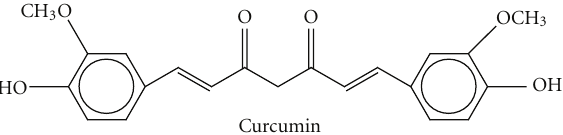
Figure 5: Chemical structure of